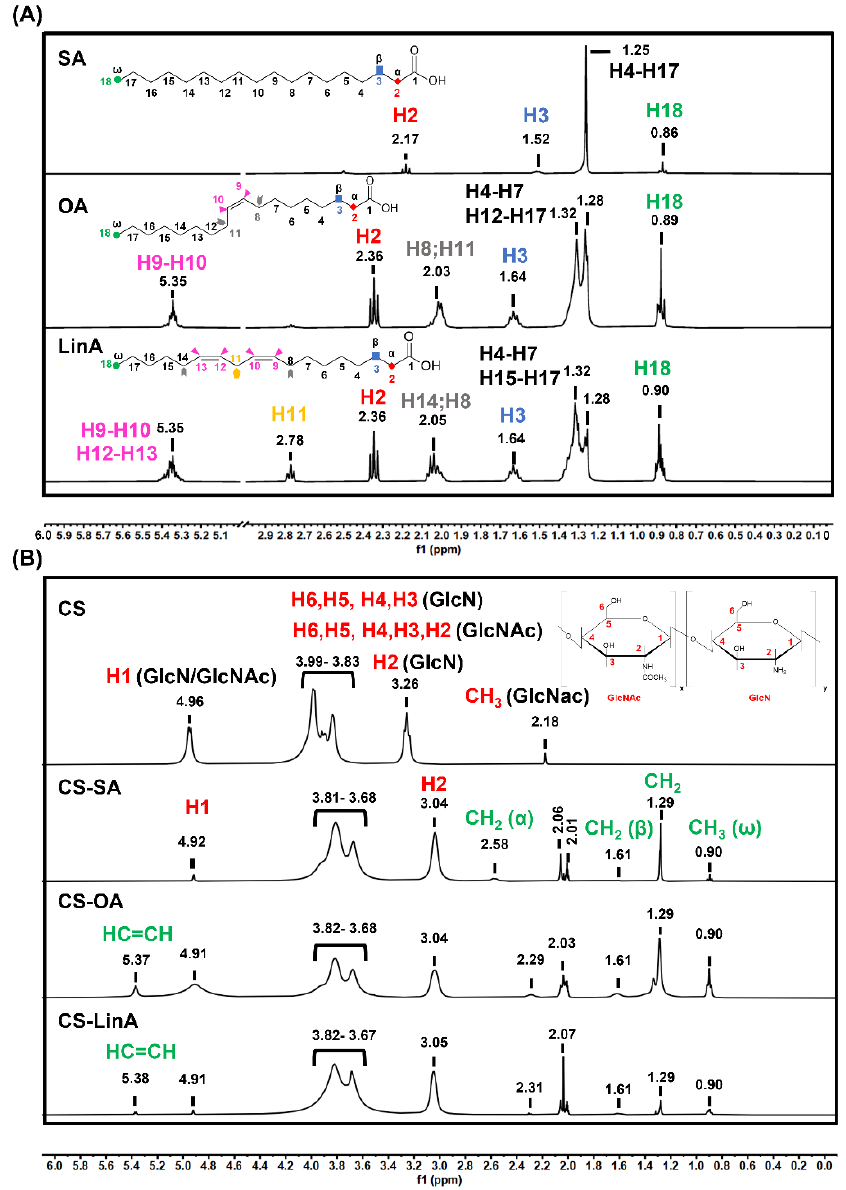
Figure 2. 1 H-NMR spectra of individual FAs ( A ), and CS and CS-FA derivatives ( B ).